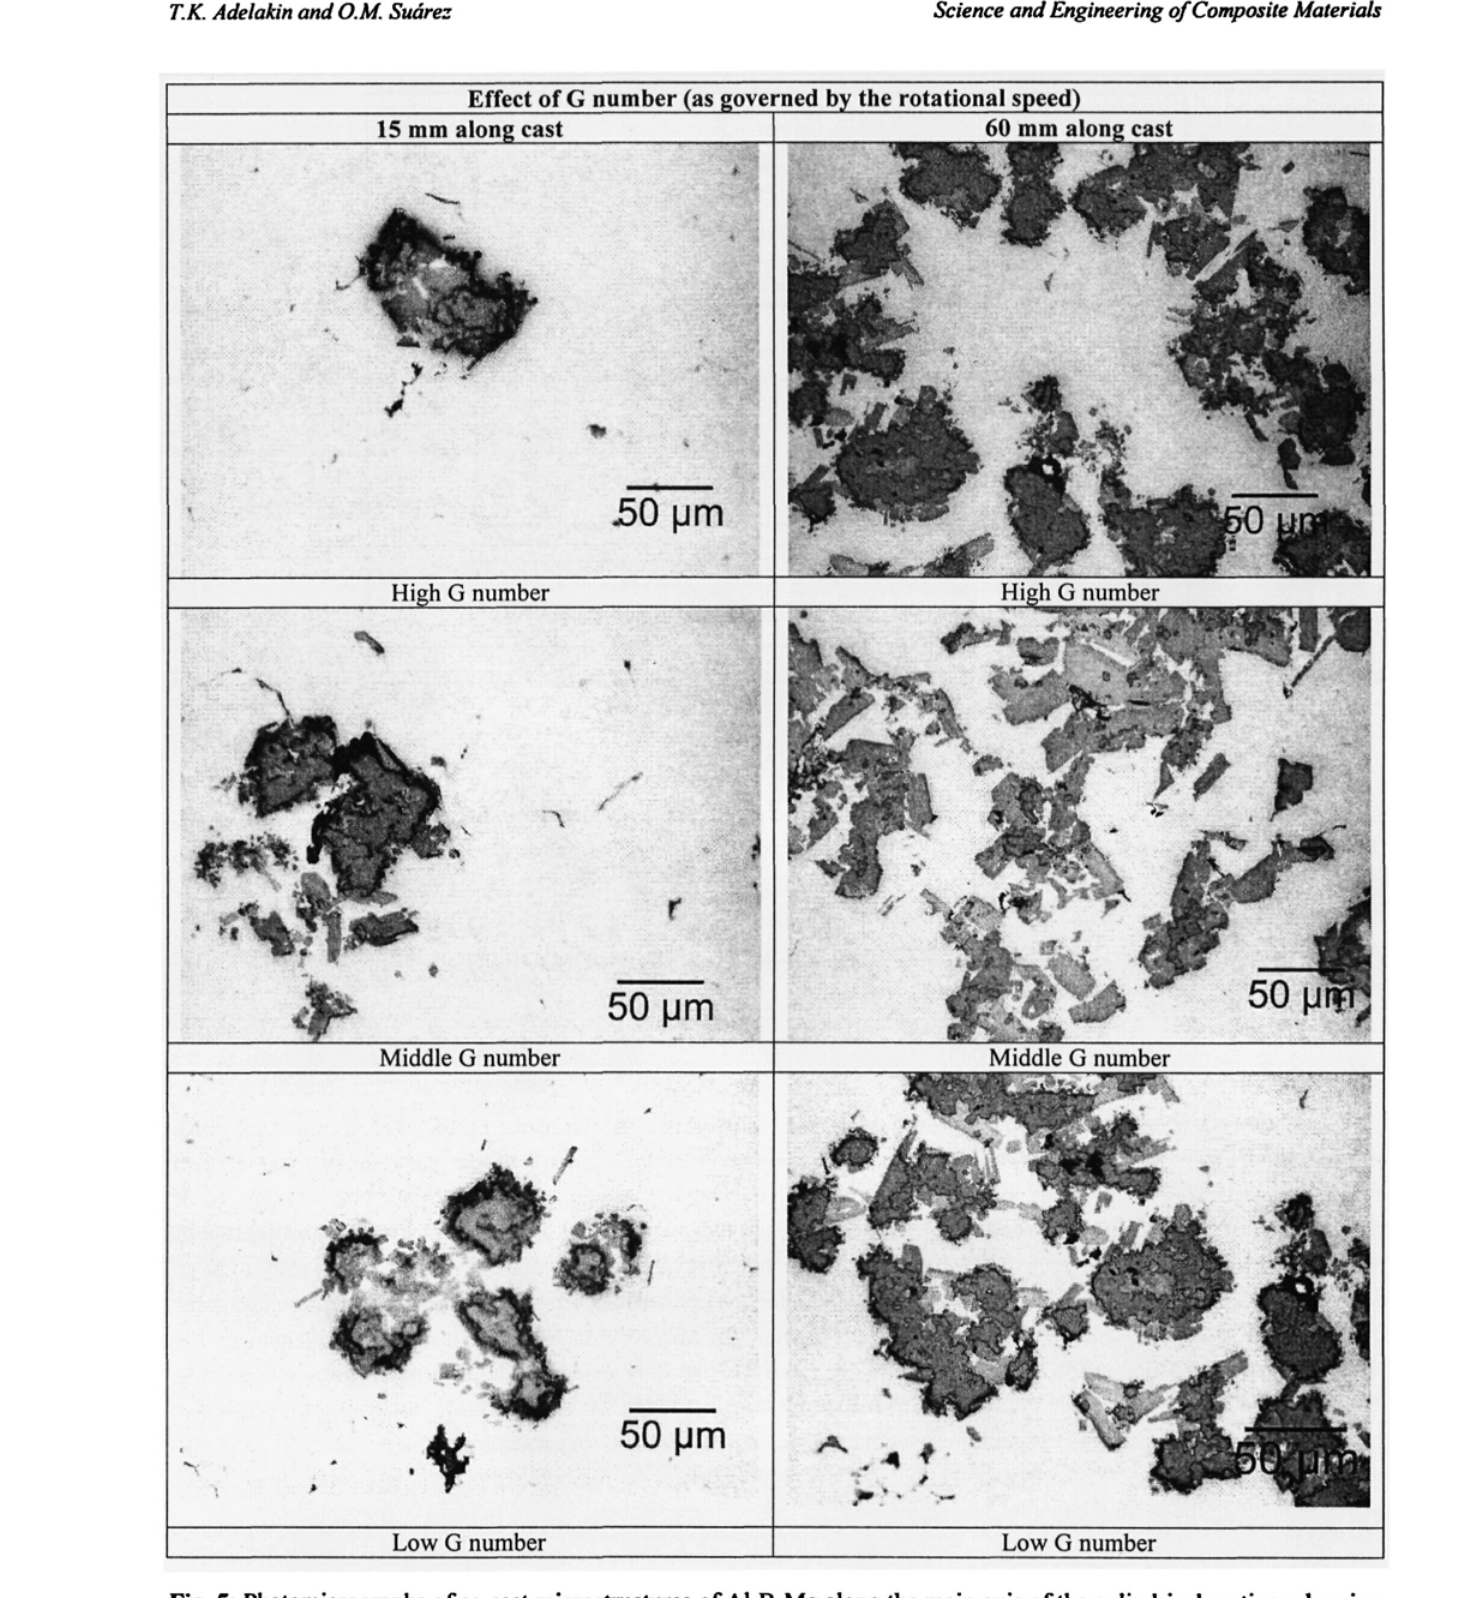
Fig. 5: Photomicrographs of as-cast microstructures of Al-B-Mg along the main axis of the cylindrical castings showing the effect of G number